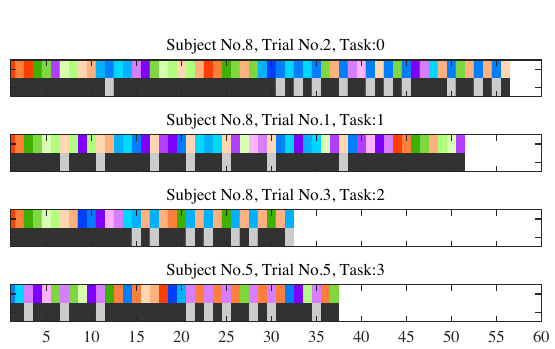
Figure 3 . Example of dwell sequences. The horizontal axis shows the index of dwells. For each sequence, the color in the top row corresponds to the color of regions in Fig. 2, and the bottom row shows the timings of dwells on the selected item by light gray